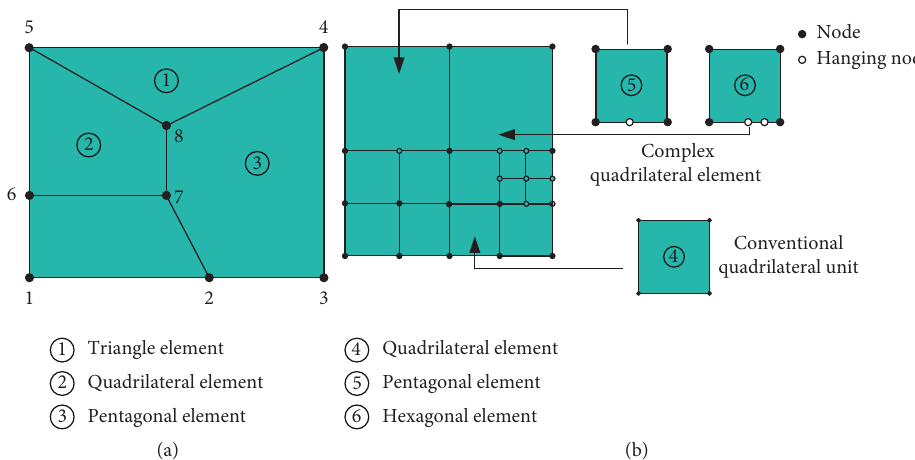
Figure 3: Schematic diagram of polygon meshes: (a) random polygon meshes and (b) quadtree meshes.